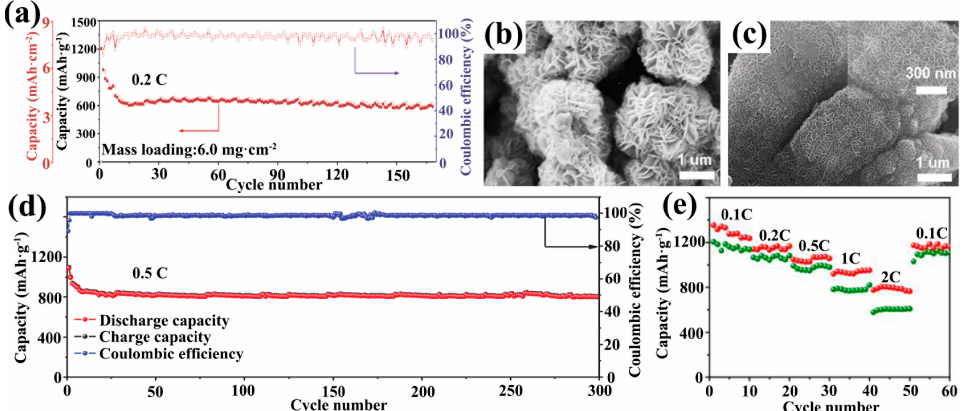
Figure 9. Cycling performance of hollow Co-CNT@MXene/S highly loaded cathode at 0.2 C ( a ) [103]. Copyright 2020, Elsevier. SEM images of 2H MoS 2 nanoflowers ( b ) and MXene/2H MoS 2 nanoflowers ( c ). Cycling performance of MXene/1T-2H MoS 2 -C-S electrode at 0.5 C ( d ) [105]. Copyright 2018, John Wiley and Sons. Rate performance of MXene@TiO 2 /S electrodes ( e ) [106]. Copyright 2018, RSC